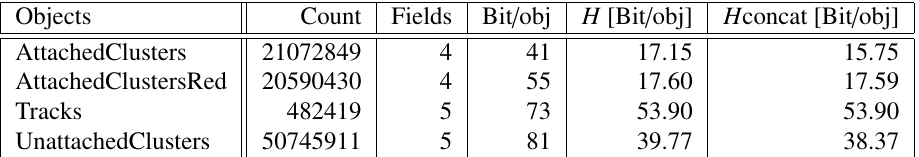
Figure 1: 482419 symbol samples from Run 3 simulation containing 344987 unique val- ues in a 24 Bit symbol range for object Tracks , array time . Entropy of the sample data is 18 . 24 Bit. Visualized with 100 bins.